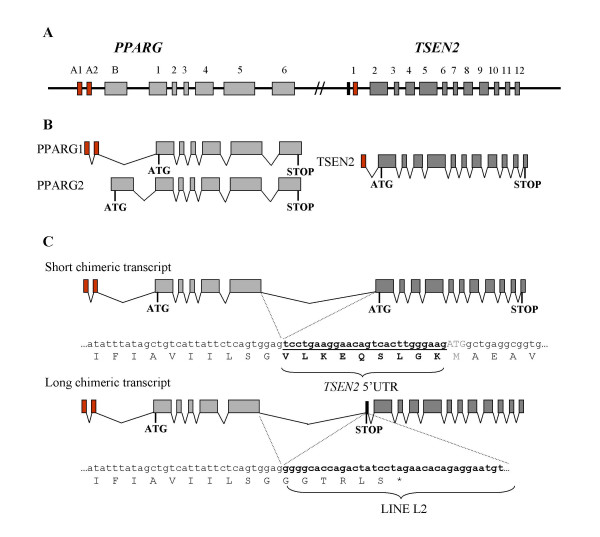
Structure of the bovine PPARG and TSEN2 genes and transcripts. A- Genomic structure of the two genes. B- Structure of the normal transcripts from both genes. C- Structure of the short and long chimeric transcripts and partial coding sequence at the junction between the two genes (untranslated exons are in red, translation start and stop are indicated).